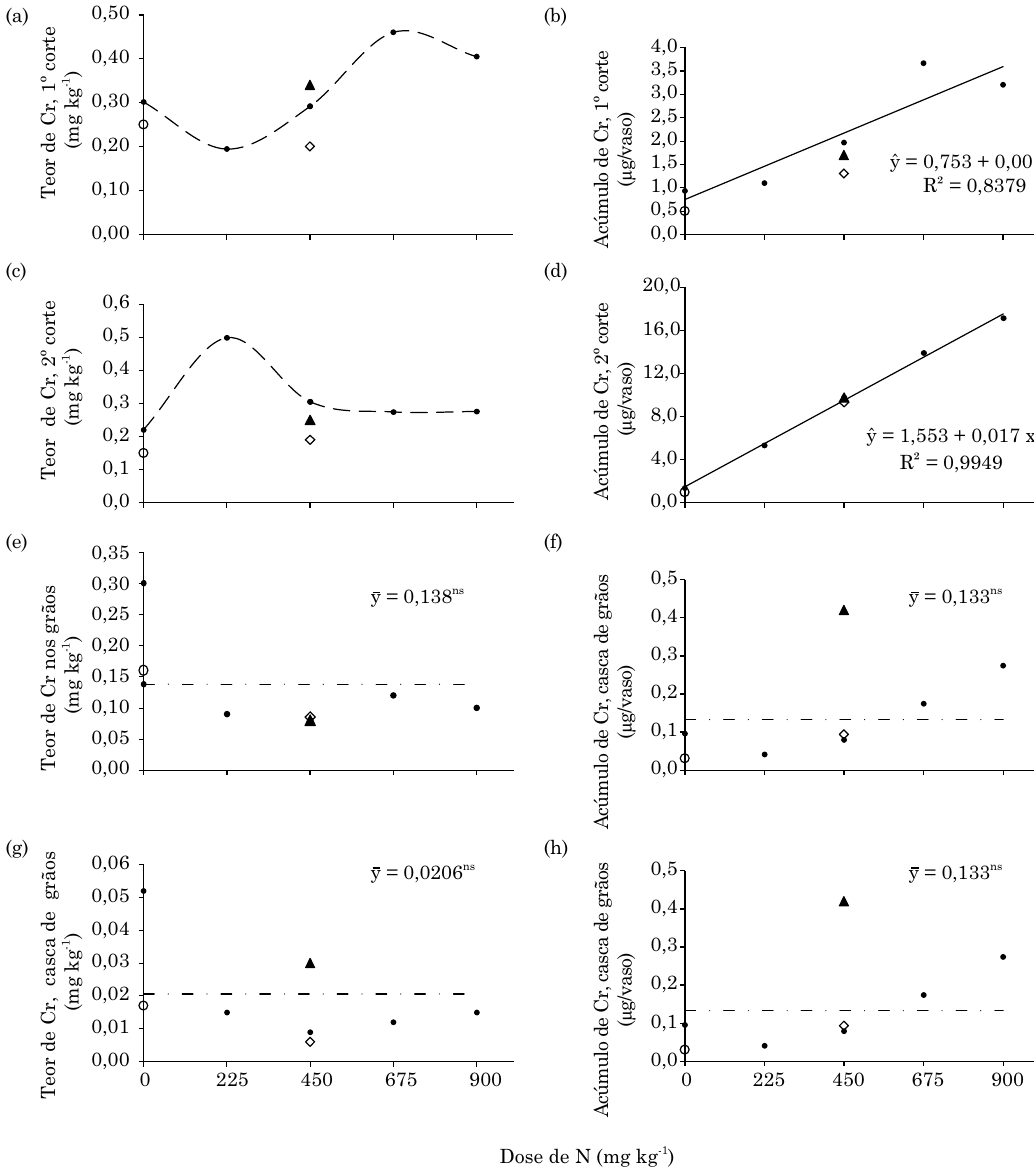
Figura 6. teor e acúmulo de cromo na parte aérea no 1º corte (a, b), no 2º corte (c, d), nas cascas de grãos (e, f) e nos grãos (g, h) em plantas de arroz submetidas a doses de nitrogênio via colágeno de curtume